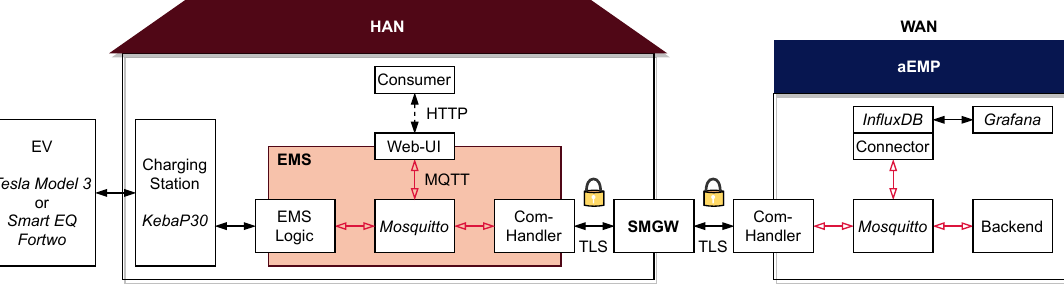
Figure 5. Detailed overview of the individual prototype components. Italics are used to mark names of